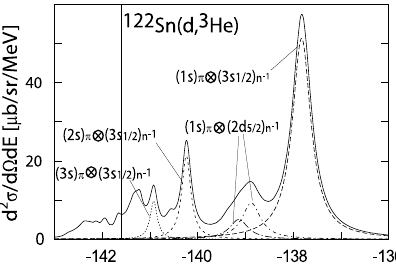
Fig. 6. Theoretical calculation by Ikeno et al. with an assumed resolution of 150 keV (FWHM) [10]. The quasi- free component is not included in the calculation. Comparison of the figures of the calculation and the data of Fig. 5 lead to the assignment of the largest peak to a configuration of ( 1s ) (cid:25) (cid:10) ( 3s 1 = 2 ) n (cid:0) 1